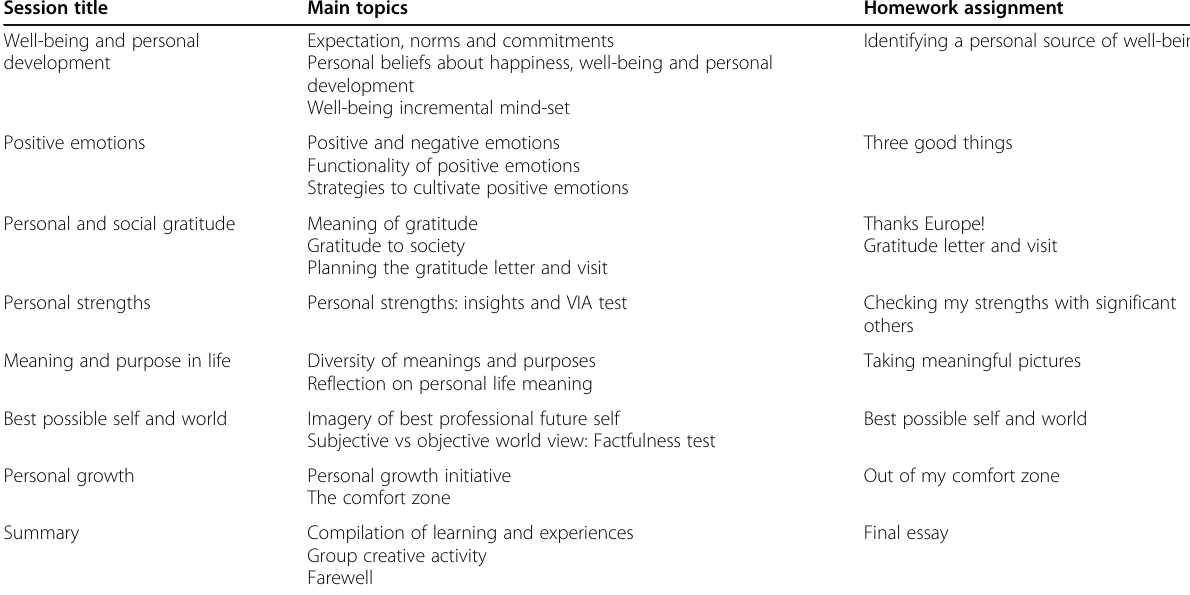
Table 1 Well-being and personal development program: summary of